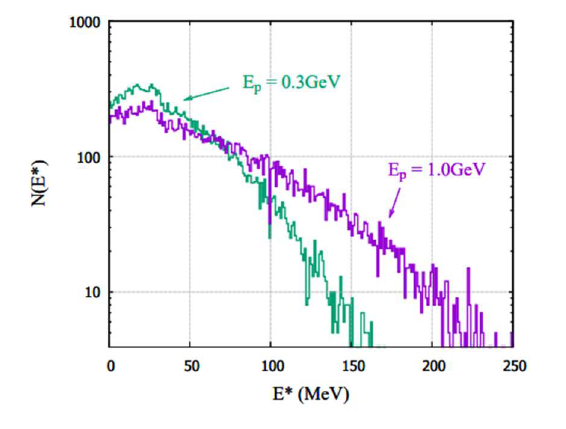
Figure 1. (Color online) Excitation energy distributions of pre-fragments produced in 𝒑 + 𝑭𝒆 𝟓𝟔 reactions at 0.3 and 1.0 GeV/A according to calculations with